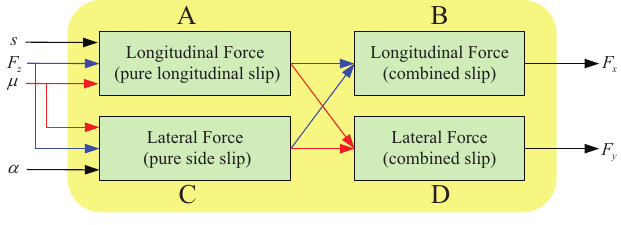
Figure 4. Structure of the Magic tire model.